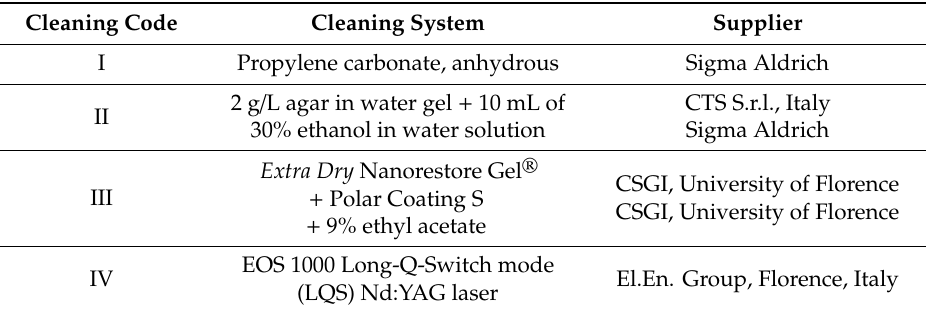
Table 2. List of the cleaning systems